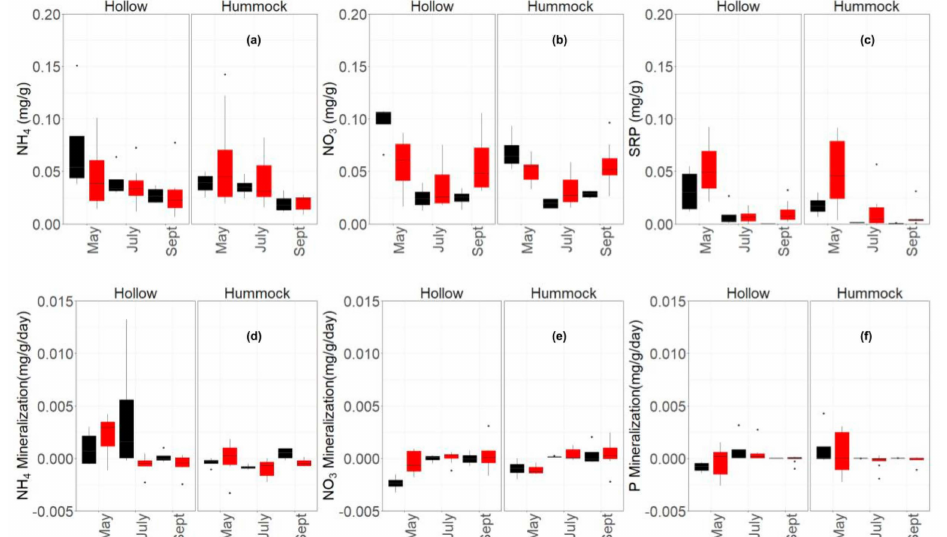
Figure 4. Extractable ( a – c ) and mineralization rates ( d – f ) for ammonium (NH 4 + ) ( a ) and ( d ), nitrate (NO 3 − ) ( b ) and ( e ), and phosphorus (SRP) ( c ) and ( f ) over the growing season (May to September 2017), with 3 study periods (early, middle, and late). Burned areas (black) and Unburned areas (red) are di ff erentiated, with microtopography shown in di ff erent panels for hollow and